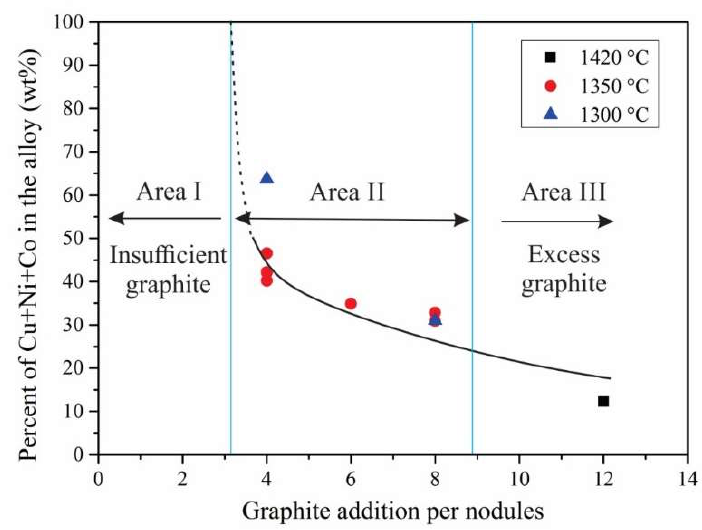
Figure 10. Relationship between alloy grade (Cu + Ni + Co) and graphite addition. Table 4. The compositions of the phases present in the quenched samples (wt%). Sample